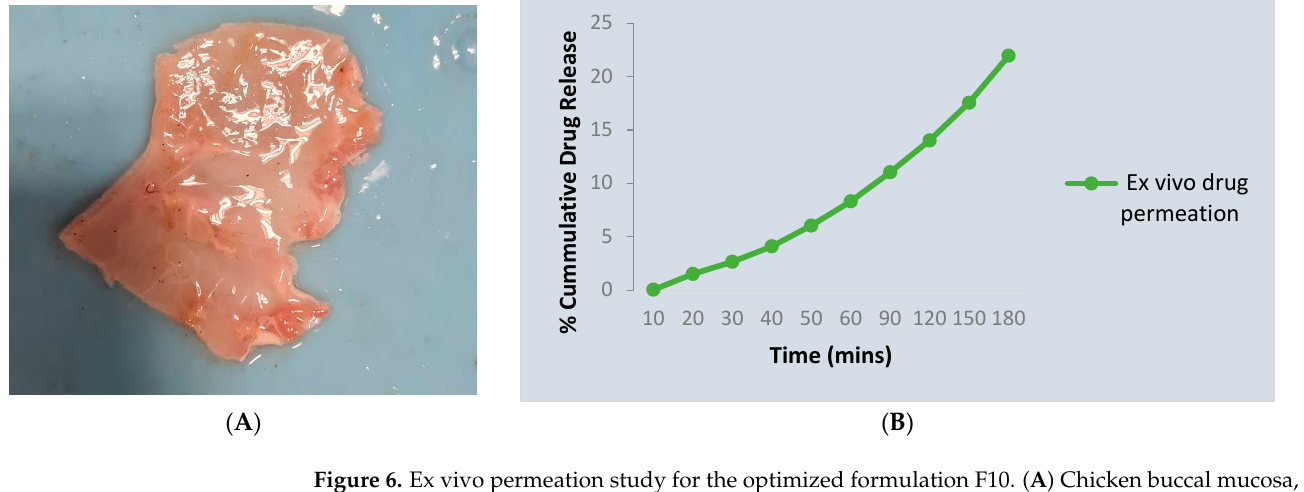
Table 4. Ex vivo diffusion study of silymarin.